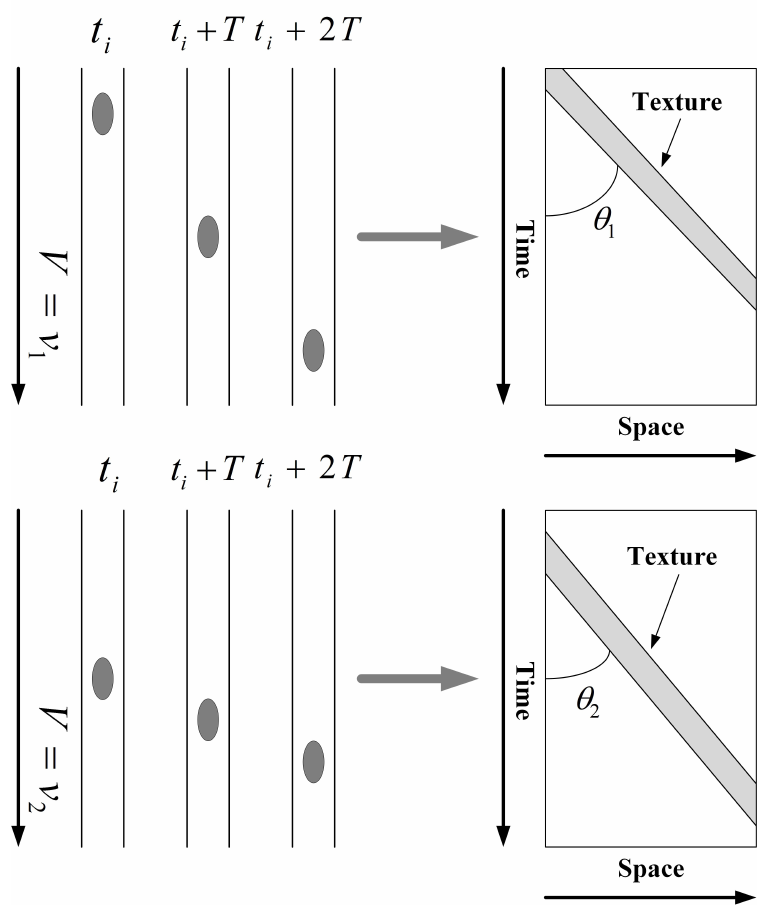
Figure 2. Schematic diagram of the principle of space-time